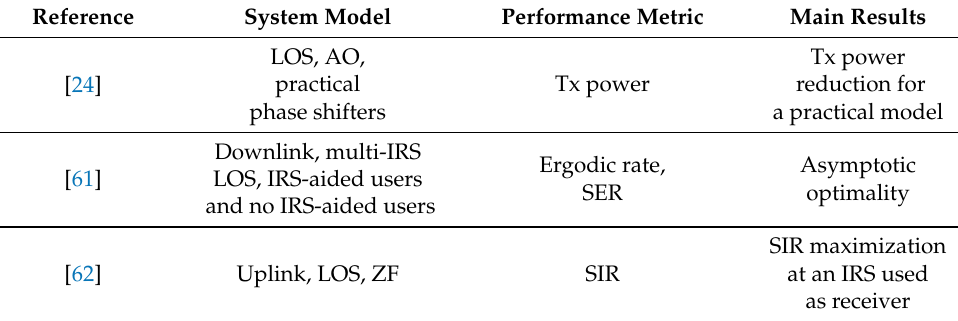
Table 4. Multiuser MISO/SIMO